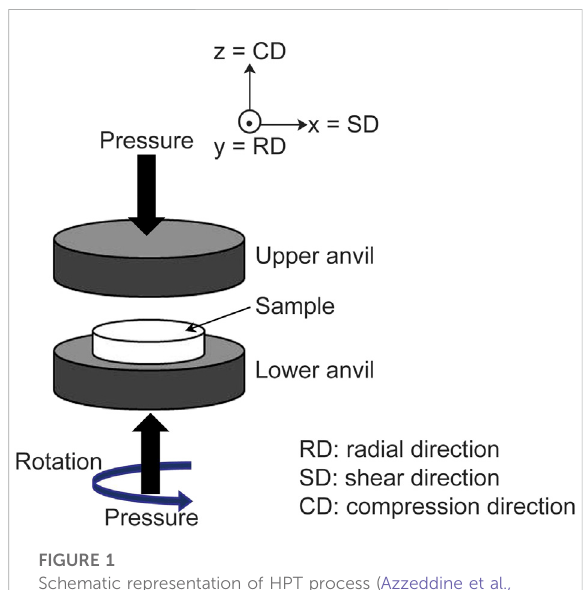
FIGURE 1 Schematic representation of HPT process (Azzeddine et al.,